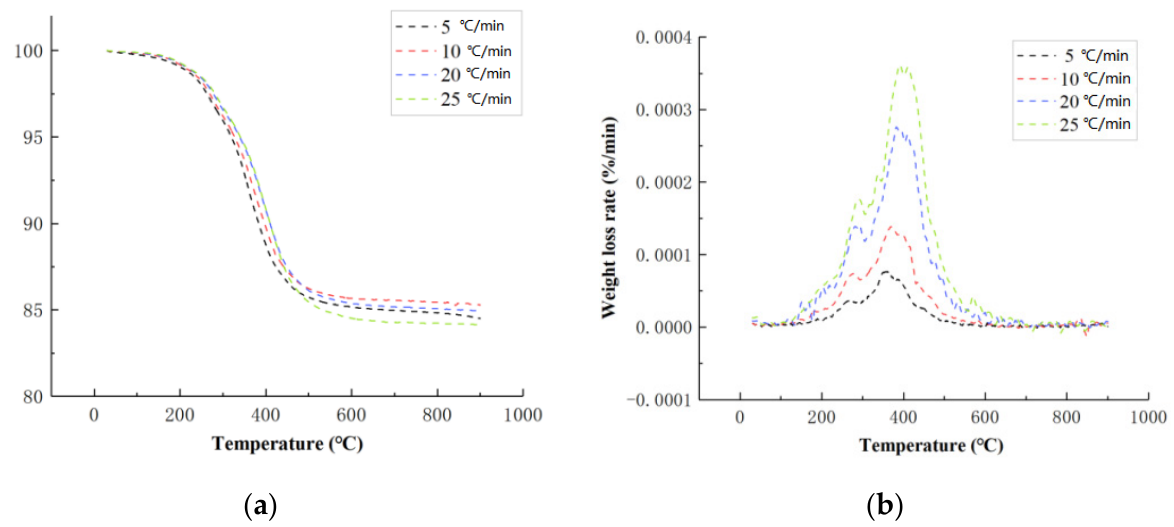
Figure 2. TGA test results of the carbon fiber composite core: ( a ) the thermogravimetric (TG) curves; ( b ) the derivative thermogravimetry (DTG) curves.